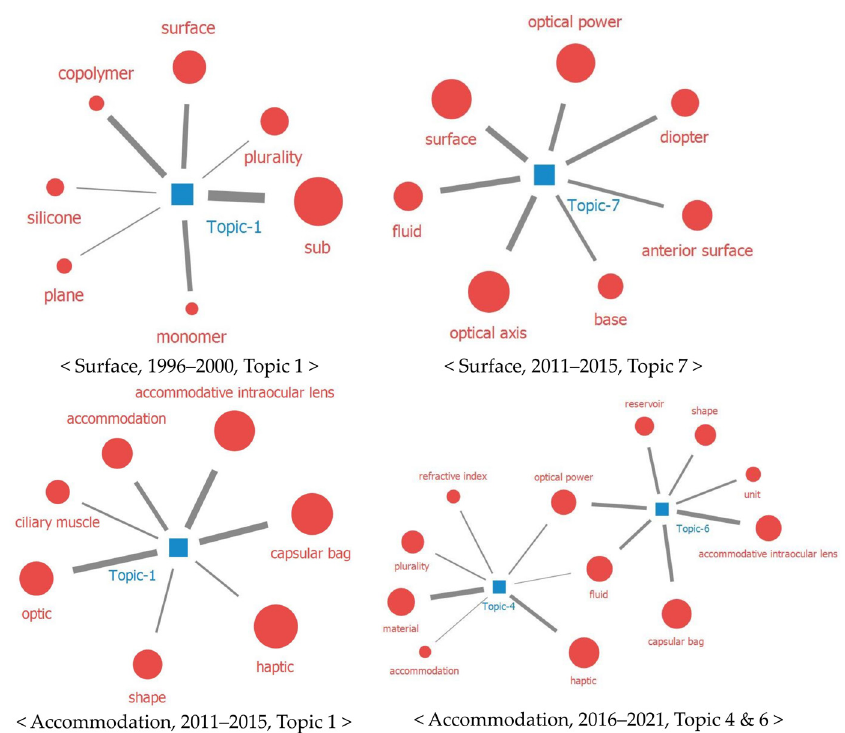
Figure 4. Topic modeling results for surface and accommodation among the 4 IOL technologies.